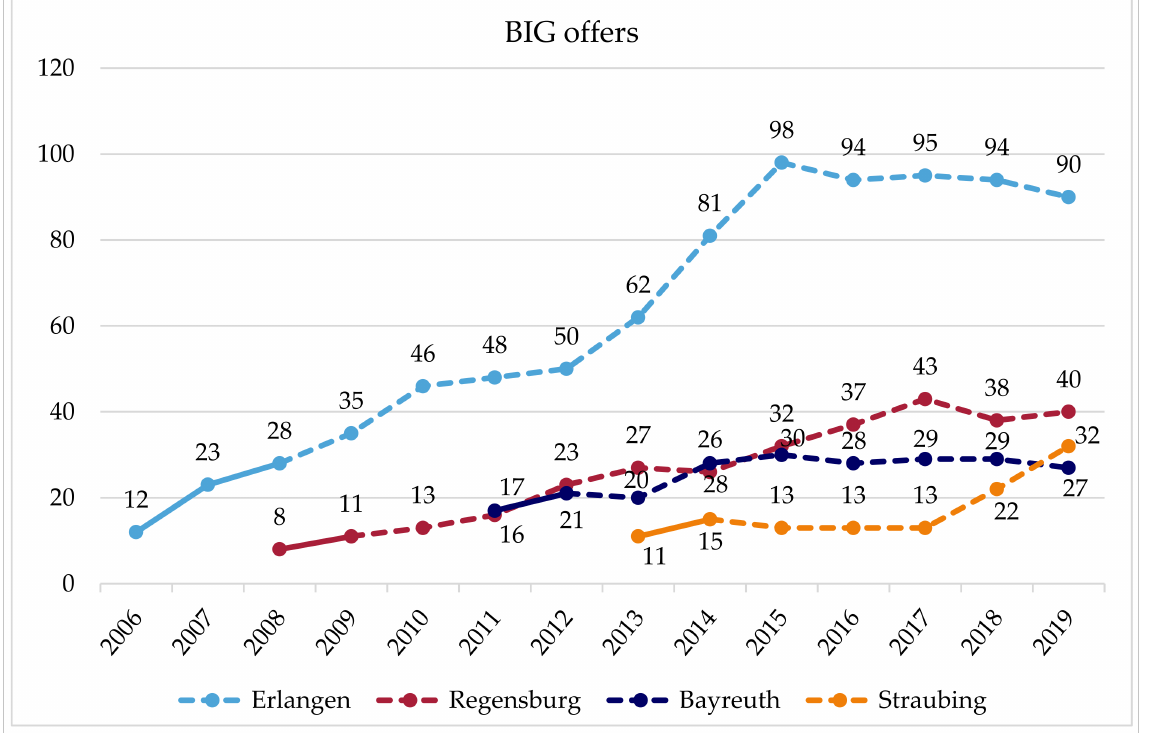
Figure 2. Number of BIG offers (all offer types) per year in four communities in Germany. Solid lines mark the years when communities received extensive support from researchers during project implementation (e.g., consultation, seed funding (Bayreuth did not receive seed